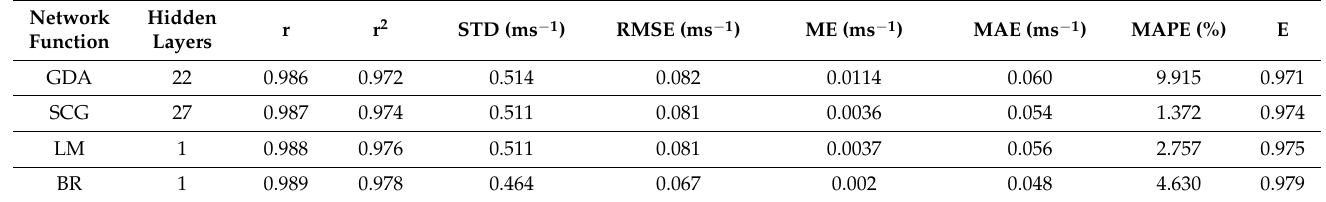
Table 1. Best-performing east network for each training function with their respective statistics, rounded to three decimal places. Network Function